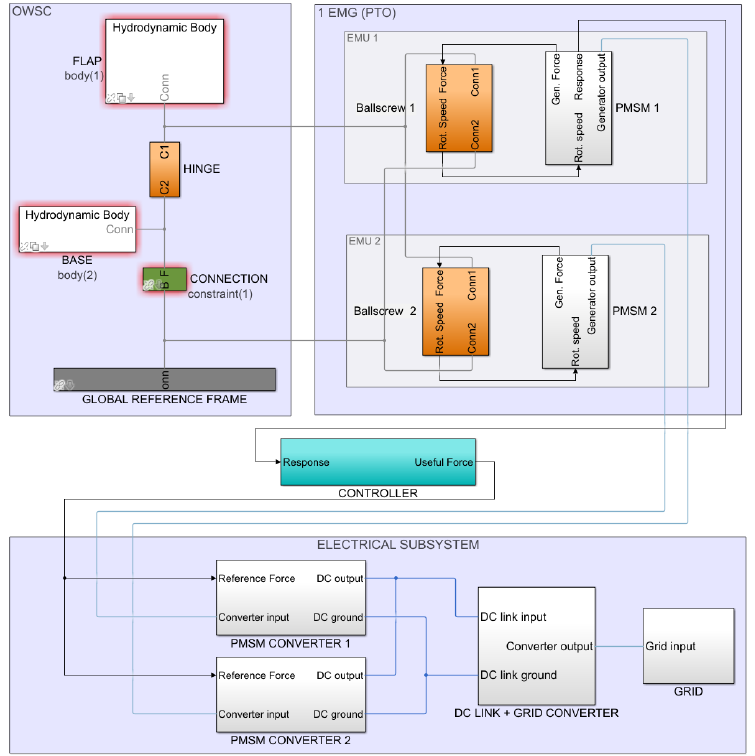
Figure 5. Offline Matlab/Simulink Model including the WEC, PTO, and control and electrical sub-